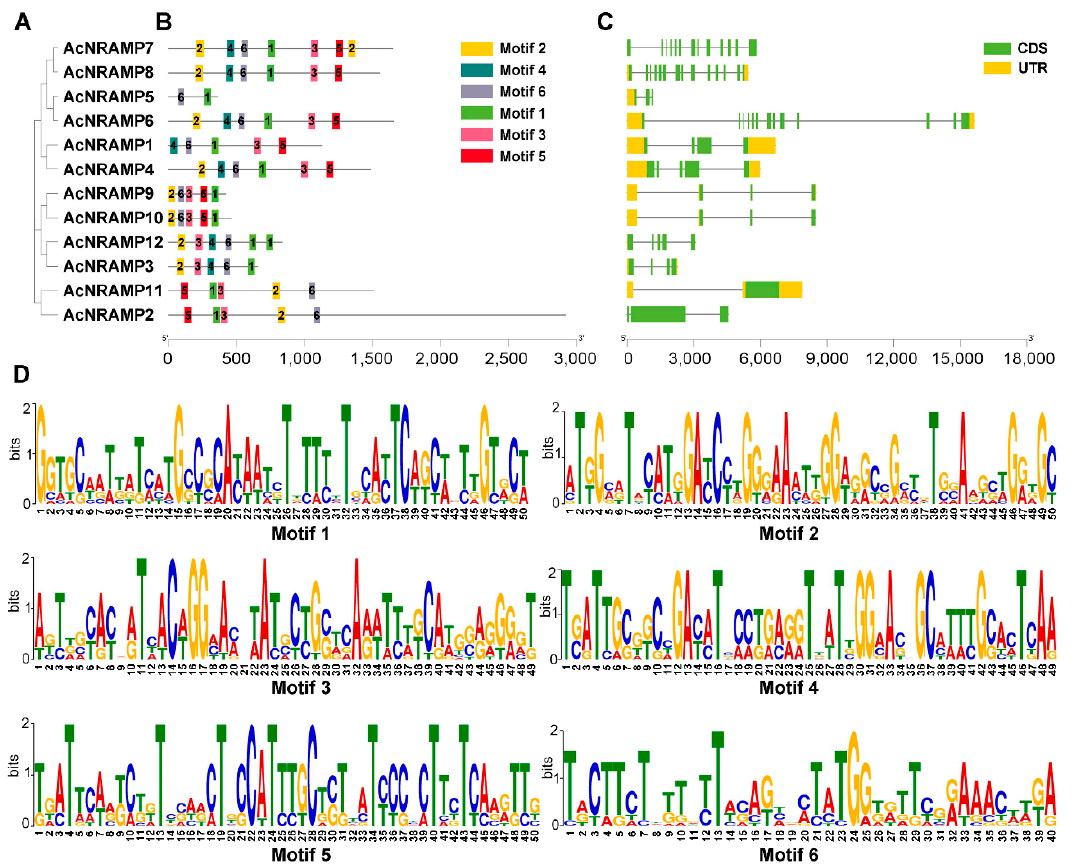
Figure 5. The sequence features of the AcNRAMP genes. ( A ) The phylogenetic tree has 12 AcNRAMPs. ( B ) The motif distribution in the 12 AcNRAMPs. The various colored rectangles represent motifs 1 to 6; the black solid lines indicate the sequences outside motifs; the bar scale below represents the number of amino acids. ( C ) The gene structures of the 12 AcNRAMP s. The green ellipses and orange ellipses represent exons and untranslated regions (UTR), respectively; the black solid lines linked with the ellipse indicate the introns; the bar scale below represents the gene length. ( D ) Sequence logos of conserved amino acid residues sequences. The X-axis represents the position of the different amino acids in each motif, while the Y-axis represents the bit value of each amino acid.